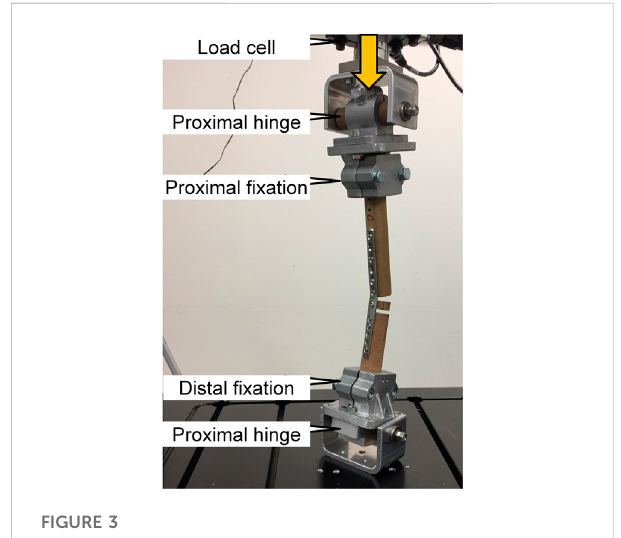
FIGURE 3 Test setup with a specimen mounted for mechanical testing, adopted from (Zderic et al.,